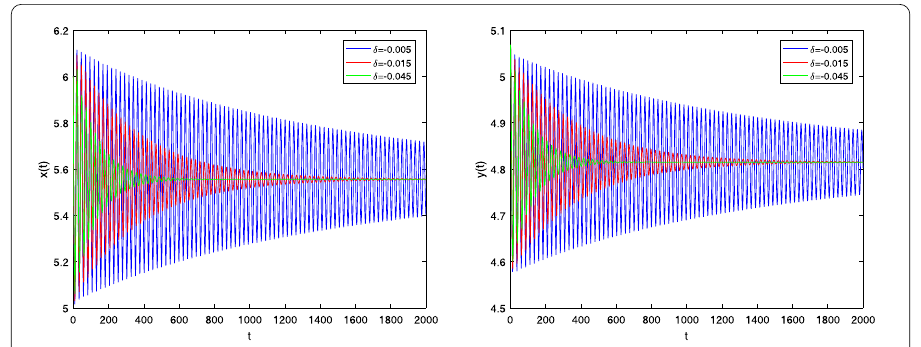
Figure 8 Waveform plots of system (4.24) with initial values (6.46,5.1) in Example 2. This figure illustrates the control effects for the pulse width p = 8 and three different control gain δ =